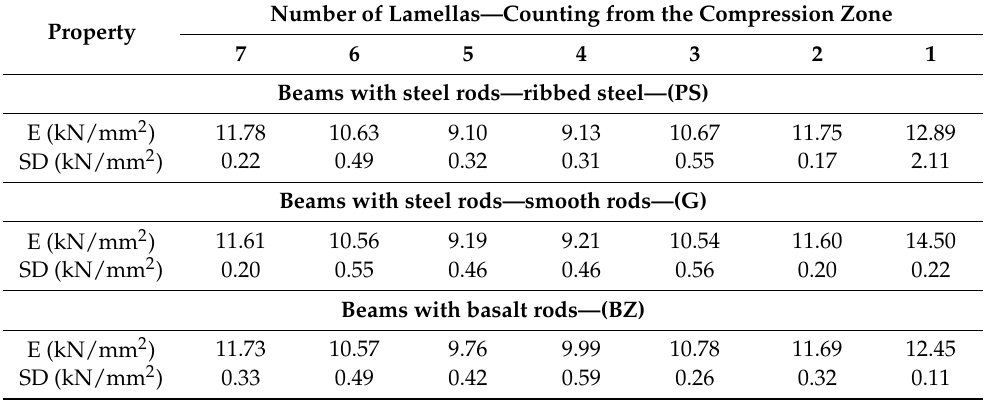
Table 2. Mean moduli of elasticity of lamellas used to manufacture beams. Property